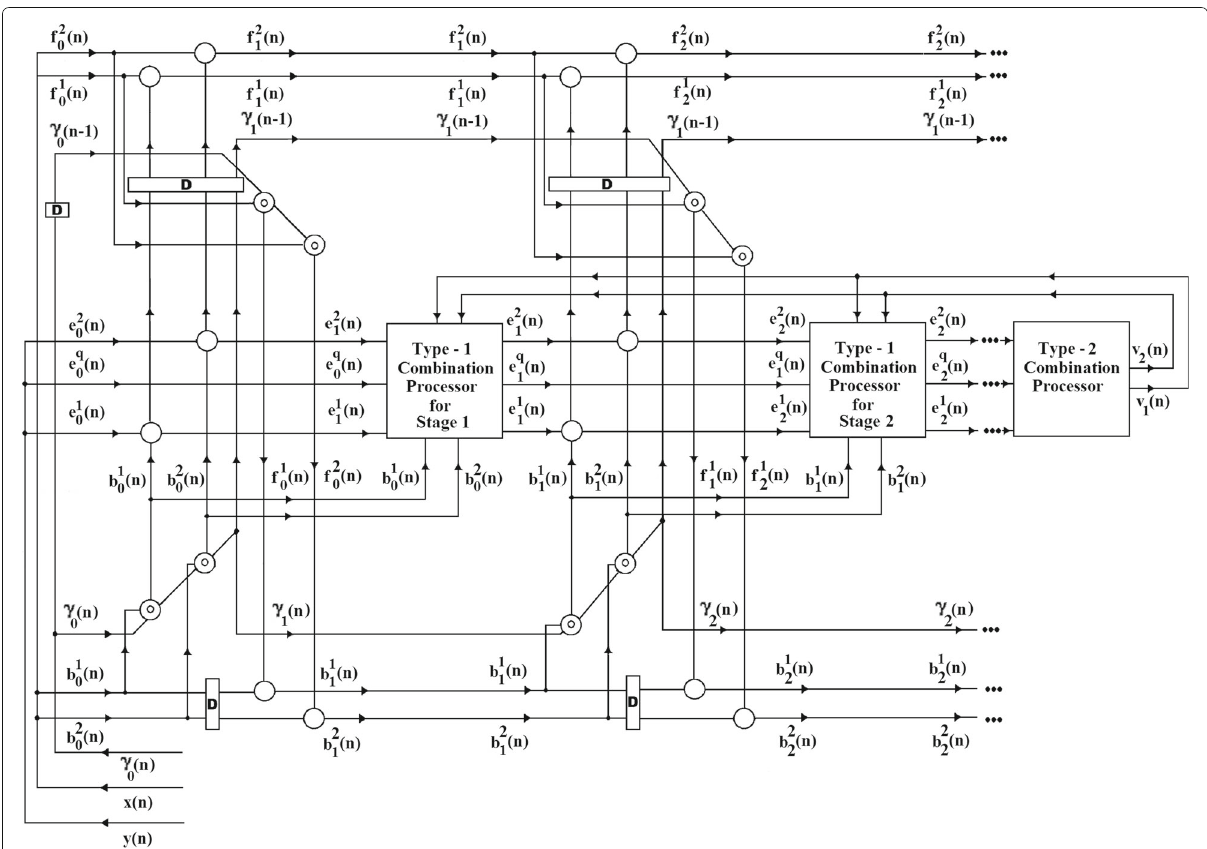
Fig. 4 A diagram of the R-CTLF scheme